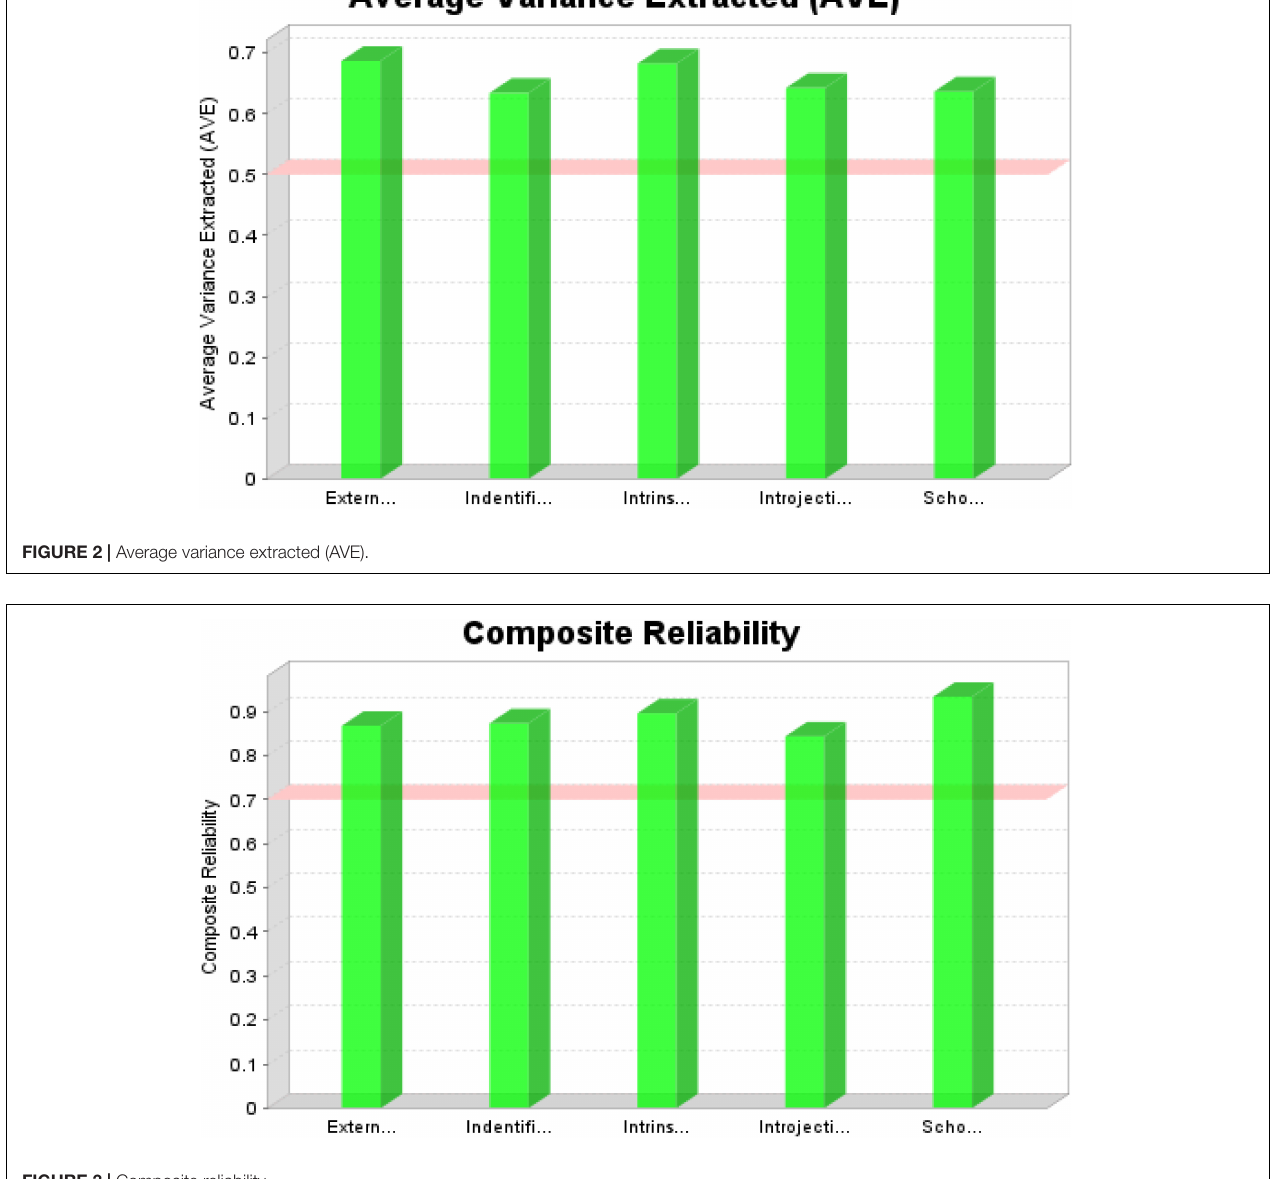
FIGURE 3 | Composite